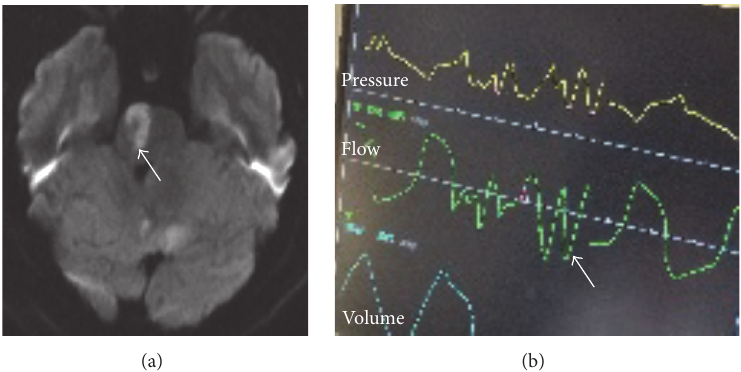
Figure 3: Magnetic resonance imaging of the brain. (a) Diffusion weighted imaging (DWI) showing right acute pontine ischemia (arrow). (b) Ventilator picture showing ataxic breathing pattern